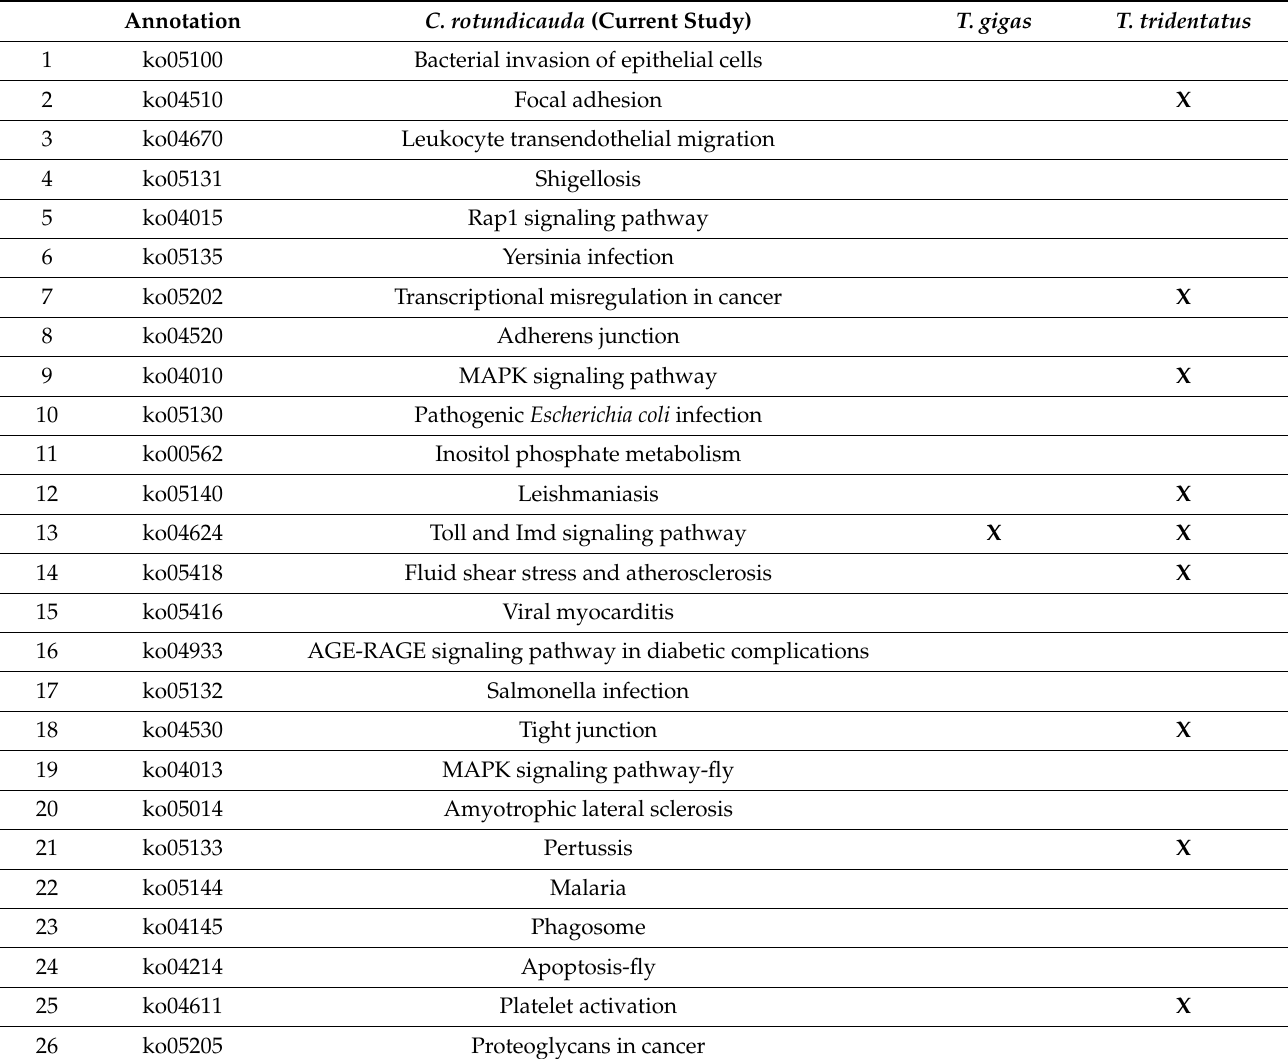
Table 3. Enriched KEGG pathways of C. rotundicauda (current study) differentially expressed genes (DEGs) compared with T. gigas [7] and T. tridentatus